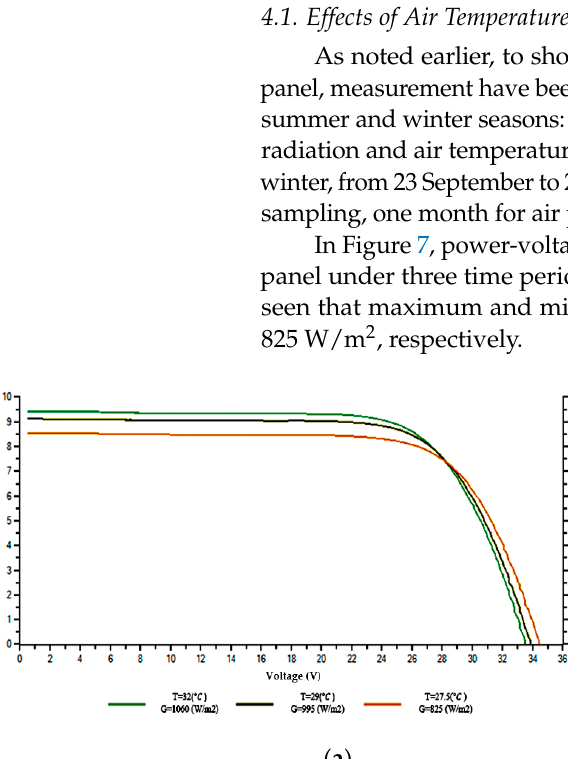
Table 2. Weather conditions for the first day (22 June 2019) of the experiment at morning time.